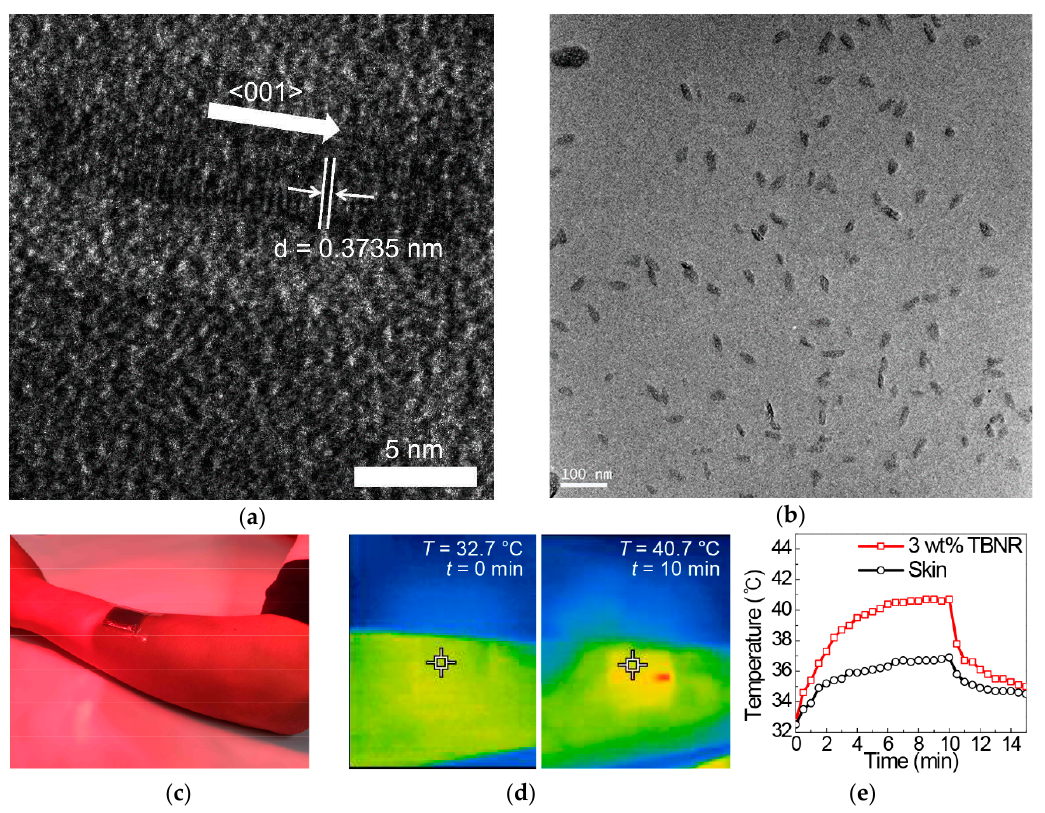
Figure 3. HR-TEM images of ( a ) Na 0.33 WO 3 TBNRs, ( b ) EPDM/TBNR nanocomposites with 3 wt % TBNR, ( c ) an optical image of an arm with a patch of a nanocomposite film with 3 wt % TBNRs under NIR irradiation by a medical NIR lamp, ( d ) NIR images of the arm at 0 and 10 min under NIR irradiation, and ( e ) photothermal temperature increases of the skin and patch including 3-wt % Na 0.33 WO 3 TBNRs under NIR light irradiation for 10 min, followed by temperature decreases after turning off the light. Reproduced from Ref. [83].